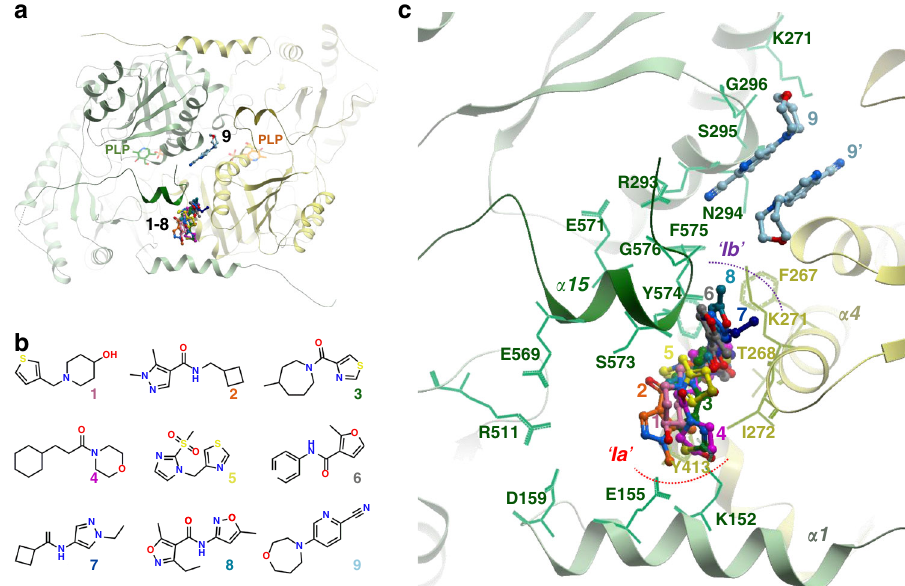
Fig. 5 Crystallography-based fragment screening of hsALAS2. a ALAS2-bound fragments are clustered into distinct regions of the protein. The two subunits of an ALAS2 homodimer are colored green and yellow. b Chemical structures of the fragments 1 – 9 , which are bound in proximity to the hsALAS2 Ct-extension. c Close-up view of the Ct-extension region of one subunit (green) and its neighboring subunit (yellow), showing the binding modes of fragments 1 – 9 . For fragment 9 , the second molecule ( 9 ′ ) bound to the yellow dimeric subunit is also